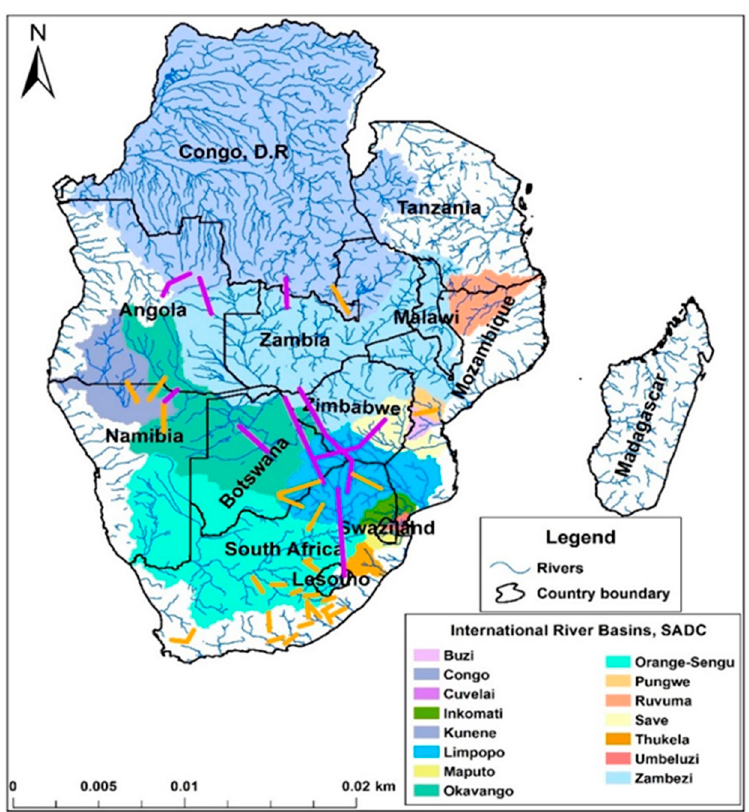
Figure 3. Planned and current inter-basin water transfers. Orange lines indicate current transfers; purple lines indicate planned transfers. Source: Developed by authors.